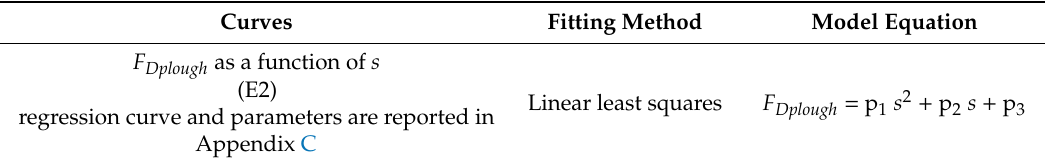
regression curve and parameters are reported